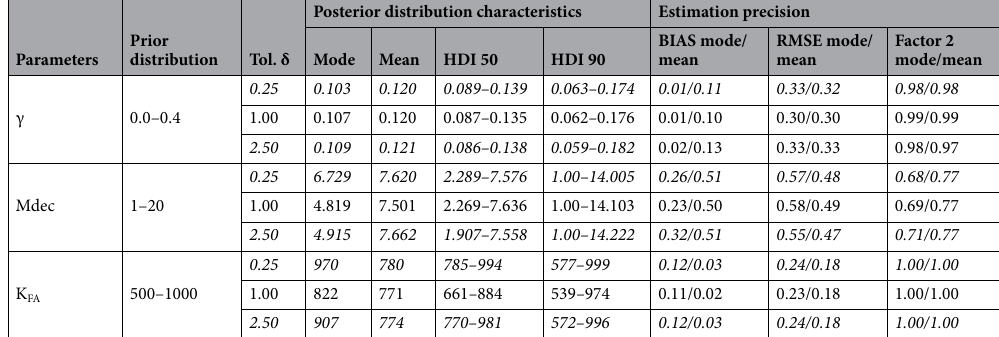
Table 3. Parameter estimation results. Limits and characteristics of the prior and posterior distributions of the parameters estimated for the Neolithic expansion along the Danubian route under Scenario SN2 with a tolerance level δ of 1% (0.25% and 2.5% in italic). γ = assimilation rate between hunter-gatherer and farmer layer; Mdec = factor of migration decreases after reaching carrying capacity in farmers; KFA = carrying capacity of the farmer demes. HDI = Highest Density Interval. The precision of the mode and the mean of the posterior distributions are also given with three statistics (BIAS, RMSE and Factor2, see text for details).